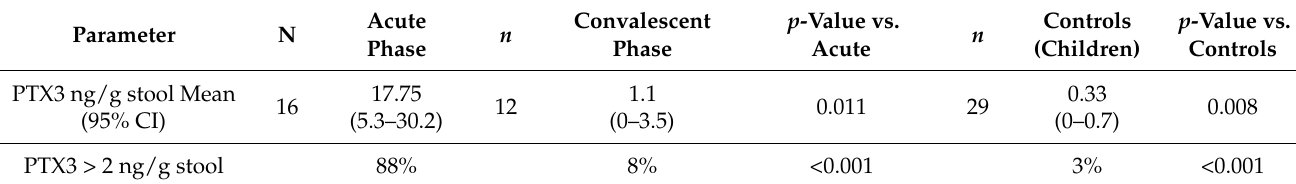
Table 3. PTX3 in stool samples of shigellosis patients and healthy